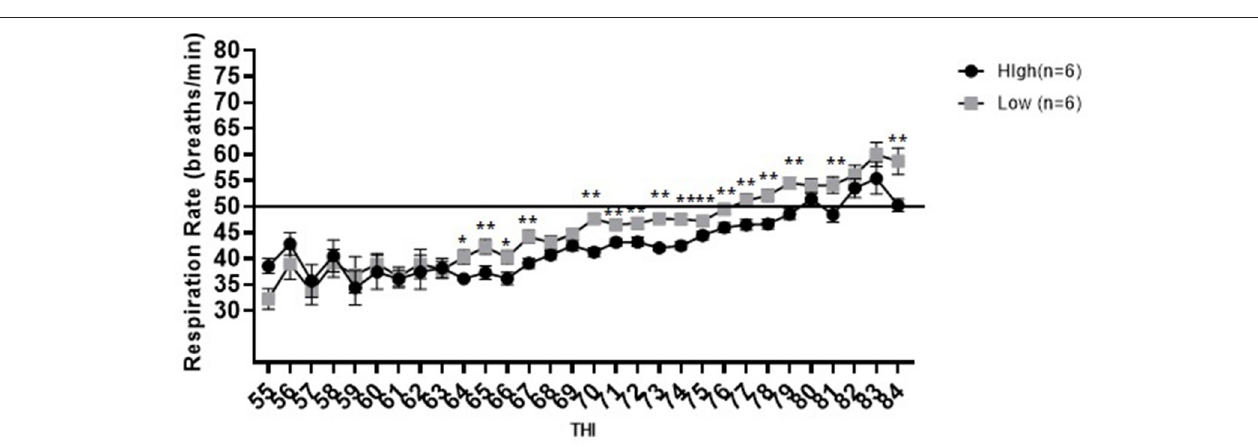
FIGURE 2 | Respiration rate in breaths per minute vs. temperature humidity index for high, average, and low immune responding dairy cattle housed in the free-stall. Data are presented as least squared means of untransformed data, with error bars representing standard error for each mean. Double stars above the error bars indicate that a significant difference [75 ( p = 0.027), 76 ( p = 0.015) and 77 ( p = 0.026)] was observed between low and high immune responders. The line at 50 breaths per minute represents the maximum normal respiration rate for dairy cattle.